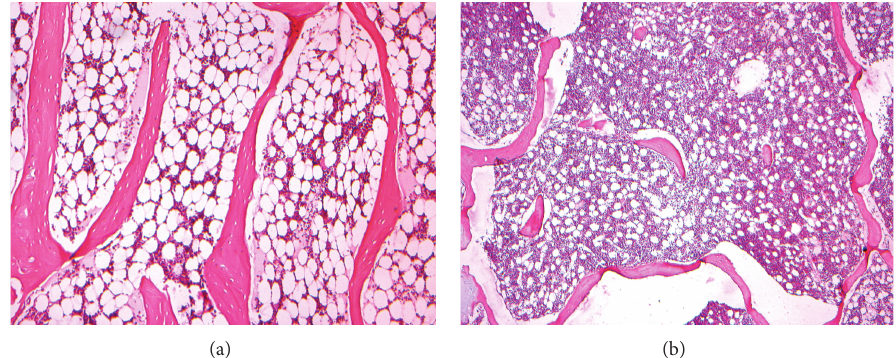
Figure 1: (a) Normal bone trabecula of vertebral in control, HE × 50. (b) Bone trabecula apparently reduced with inflammatory cells infiltration after PMMA injected 24h, HE × 50.